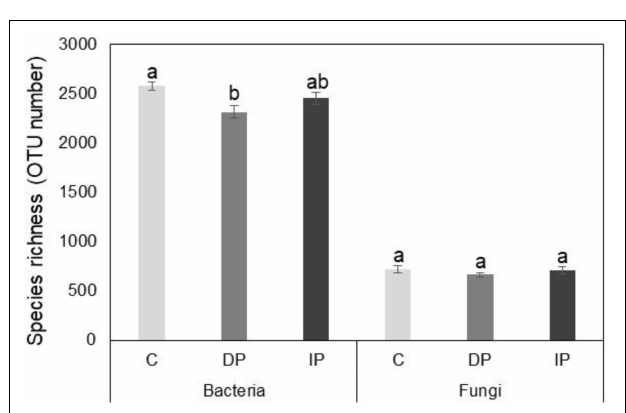
FIGURE 1 | Effect of increasing precipitation (IP) and decreasing precipitation (DP) on species richness of soil bacteria and fungi. C represents control. Different letters indicate significant differences based on p <